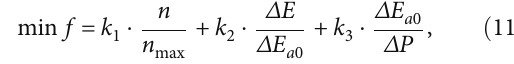
Figure 3: Schematic of the projectile correction process.